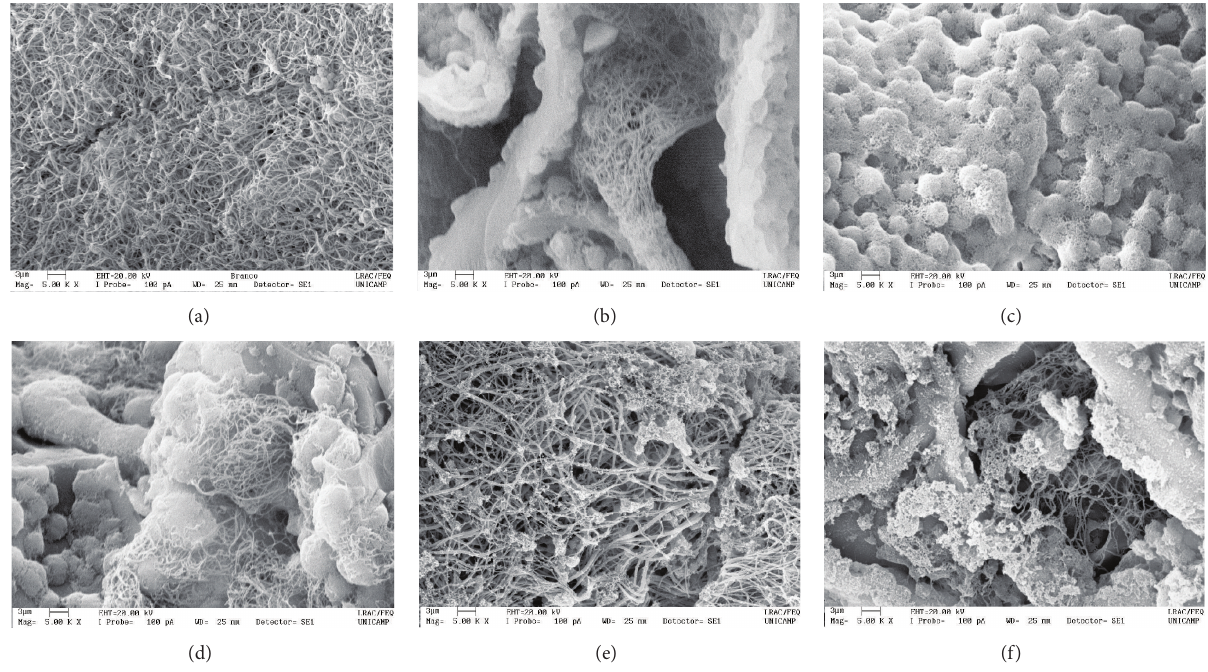
Figure 4: Scanning electron microscopic images of 𝑎 P-PRP/PCHTs after 5 days of cultivation of h-AdMSCs. (a) 𝑎 -PRP; (b) 𝑎 P-PRP/PCHTs 1% ( − 20 ∘ C); (c) 𝑎 P-PRP/PCHTs 2% ( − 20 ∘ C); (d) 𝑎 P-PRP/PCHTs 3% ( − 20 ∘ C); (e) 𝑎 P-PRP/PCHTs 3% ( − 80 ∘ C); and (f) 𝑎 P-PRP/PCHTs 3% ( − 196 ∘